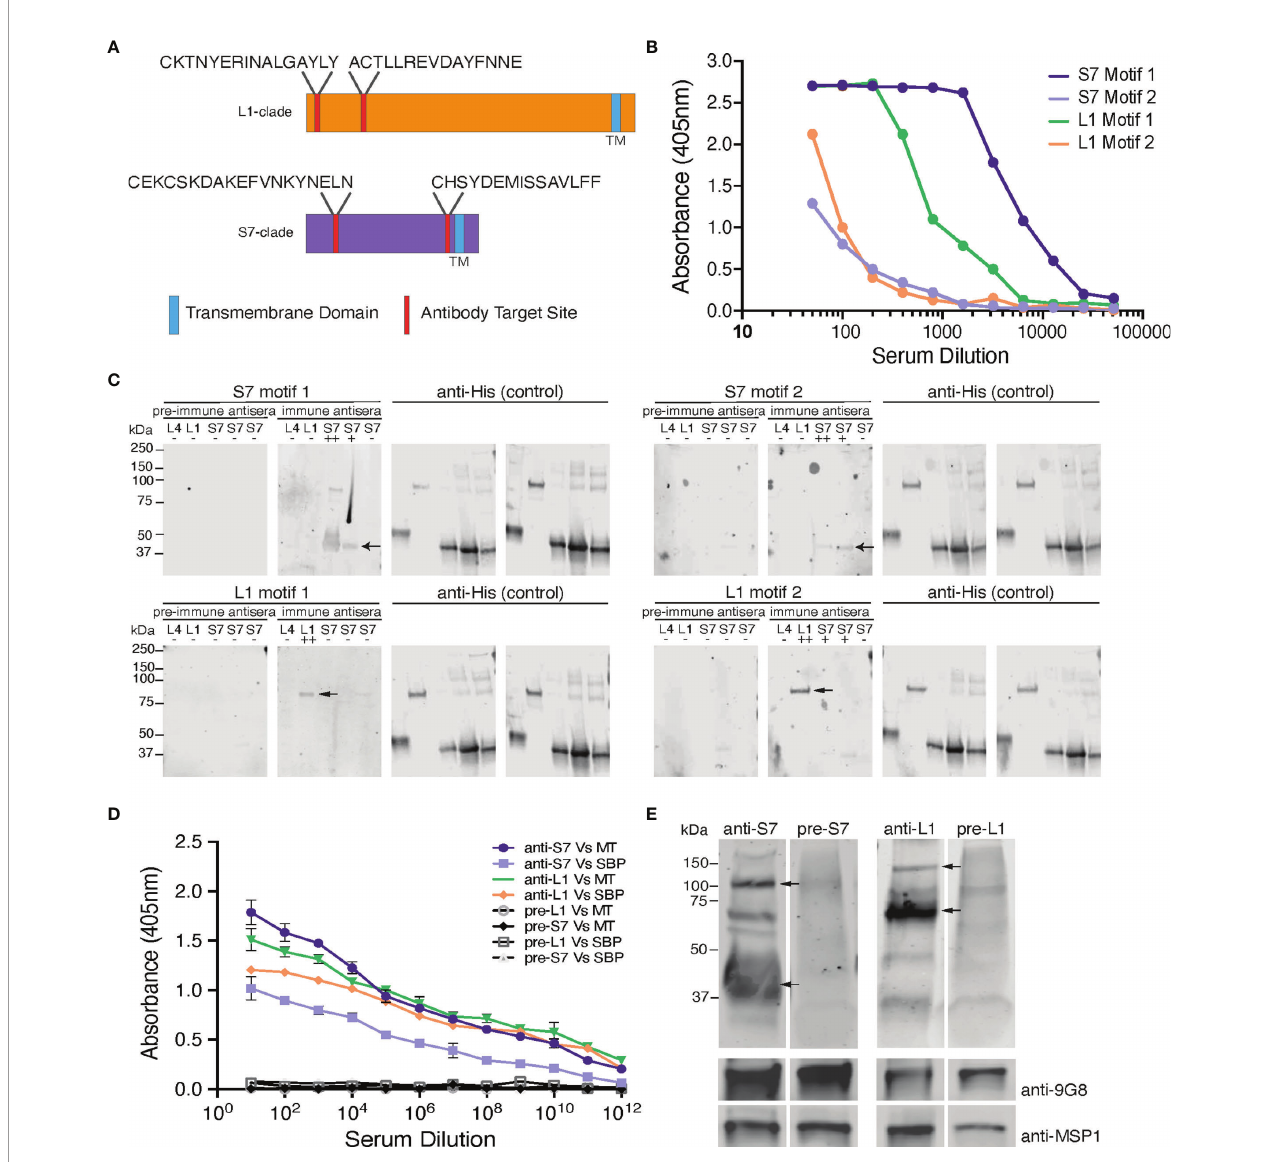
FIGURE 1 | Design and validation of the anti-S7 and anti-L1 peptide antisera. (A) Schematic model of S7- and L1-clade proteins showing position of the designed target peptide motifs. One of the S7 target motifs is located towards the N-terminus of the S7 protein clade, while the other is located further towards the C- terminus. Both the target motifs identi fi ed in the L1 PIRs are located towards the N-terminus of the protein sequence. TM, Transmembrane Domain. (B) ELISA reactivity of the individual anti-S7 and anti-L1 peptide sera (anti-S7 motif 1 peptide antiserum, anti-S7 motif 2 peptide antiserum, anti-L1 motif 1 peptide antiserum, anti-L1 motif 2 peptide antiserum) against the target P. chabaudi PIR peptides that were used to immunise rabbits. ELISAs performed by Cambridge Research Biomedicals, and fi gure adapted from those supplied by Cambridge Research Biochemicals. (C) Western blot analysis of S7, L1 and L4 his-tagged recombinant proteins probed with the individual anti-S7 and anti-L1 peptide antisera. Migration of S7 proteins was between 33-37 kDa markers and of L1 proteins between the 75-150 kDa markers (arrows indicate monomers). Probing against the his-tag served as loading control. Pre-immune sera served as negative controls, where they were found to be unreactive and did not recognise any of the recombinant proteins, con fi rming the lack of pre-existing reactivity to PIRs in the rabbit serum. ++ denotes a protein that highly matches the sequence of the peptide motif that the sera were raised against; + denotes a protein that contains a similar peptide motif (50-60% alignment) to that used for raising the immune sera; - denotes a protein that it does not contain any of the anti-sera target motifs. The speci fi c recombinant proteins loaded are the PCHAS_0600600 (L4), PCHAS_1100300 (L1), PCHAS_0400300 (S7), PCHAS_1200500 (S7) and PCHAS_1300101 (S7). (D) ELISA reactivity of the pooled anti-S7 and anti-L1 peptide sera (pooled motif 1 and 2 for each antiserum) against WT parasite lysates extracted from MT and SBP acute- stage parasites. Pre-immune serum served as negative control. OD 405 ± standard deviation of three replicate assays is shown. MT, Mosquito Transmitted; SBP, Serially Blood Passaged. (E) Western blot analysis of whole parasite lysates (reducing conditions) prepared from P. chabaudi MT WT parasites at the trophozoite- stage, using the anti-S7 and anti-L1 pooled peptide immune sera. Arrows indicate the estimated average size of the monomers or dimers of each PIR clade (S7 33- 50 and 100 kDa; L1 75-150 kDa). Probing with the pre-immune sera served as negative control. Probing against the Plasmodium EXP2 was used as stage-speci fi c and loading control. The molecular weights on the right indicate the positions to which size markers had